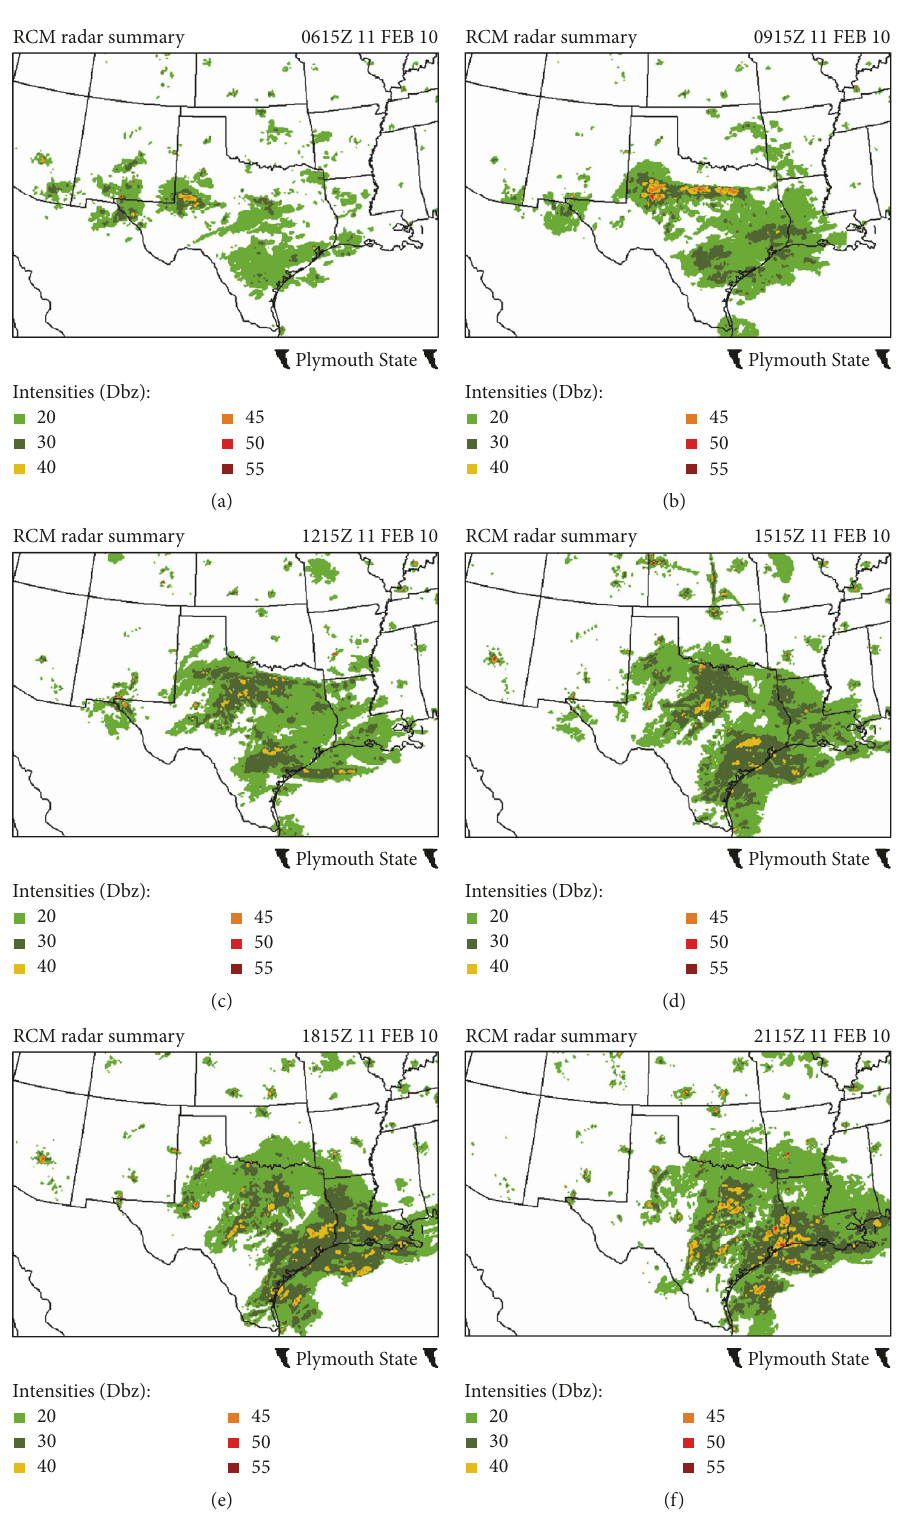
Figure 3: Plymouth State Weather Center radar summary (Dbz) valid at (a) 0615 UTC, (b) 0915 UTC, (c) 1215 UTC, (d) 1515 UTC (e) 1815 UTC, and (f) 2115 UTC 11 February